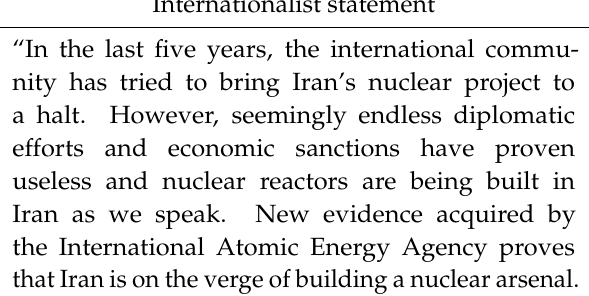
Table 1: Transcripts of Presidential Statements Nationalist statement Internationalist